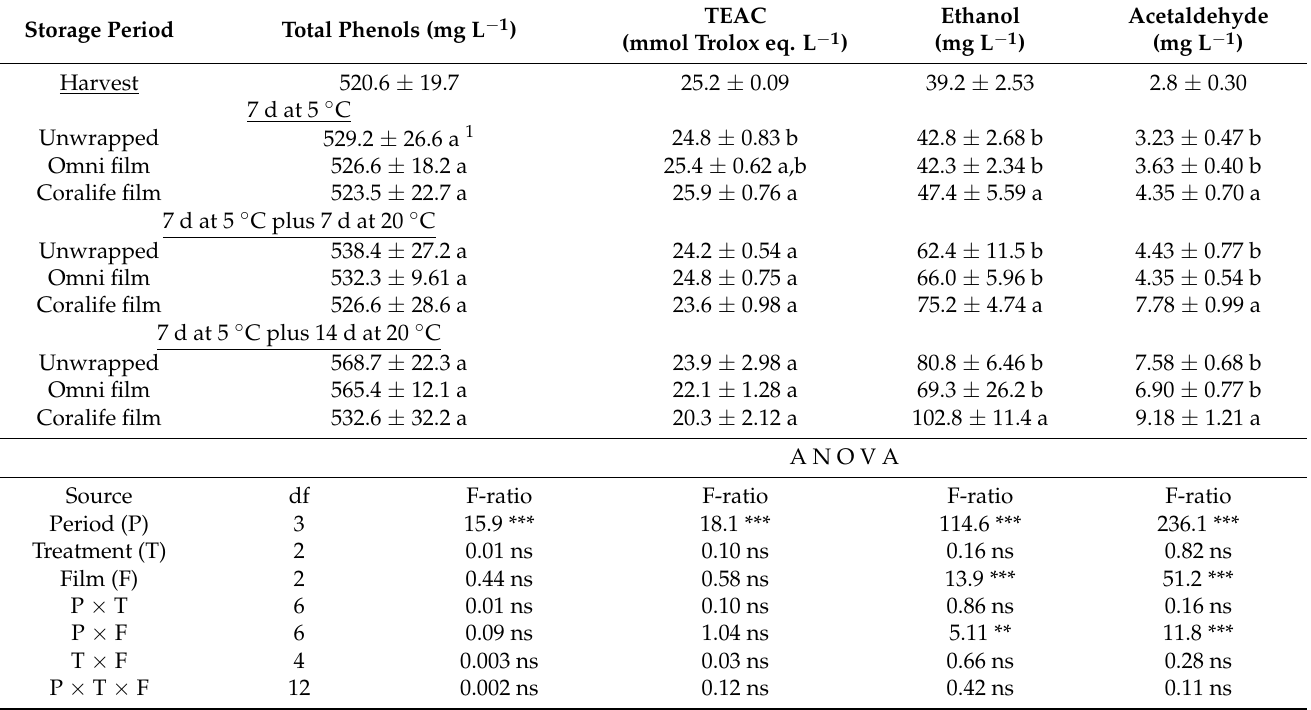
Table 4. Juice total phenols, antioxidant activity (TEAC), ethanol, and acetaldehyde content of ‘Simeto’ mandarins after seven days at 5 ◦ C and 85–90% RH, plus seven or fourteen days at 20 ◦ C and 55–60% RH.